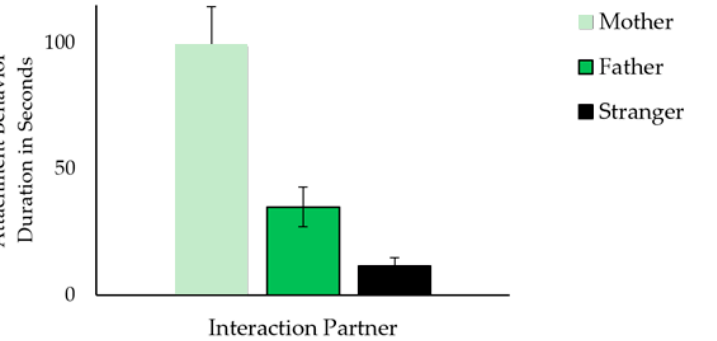
Figure 1. Duration of attachment behaviors towards mother, father, and stranger (means and SE).